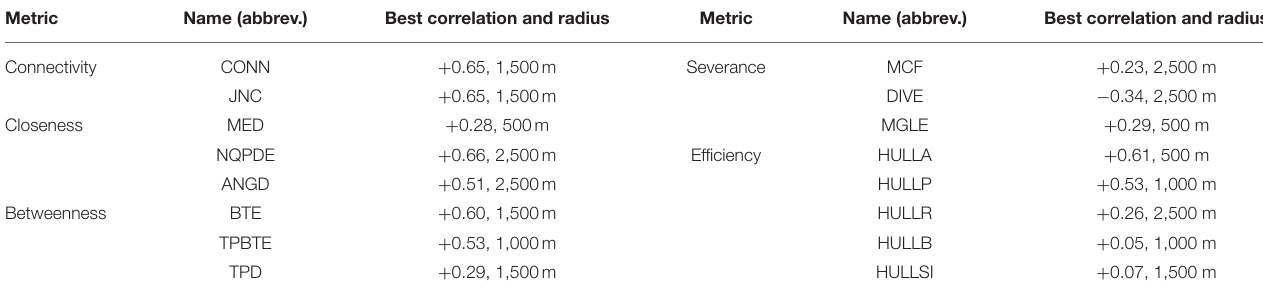
TABLE 2 | The correlation between street network metrics and urban vitality. Metric Name (abbrev.) Best correlation and radius Metric Name